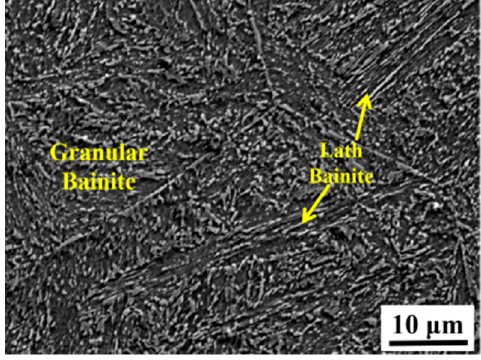
Figure 13. Microstructure of the specimen after CLSM.